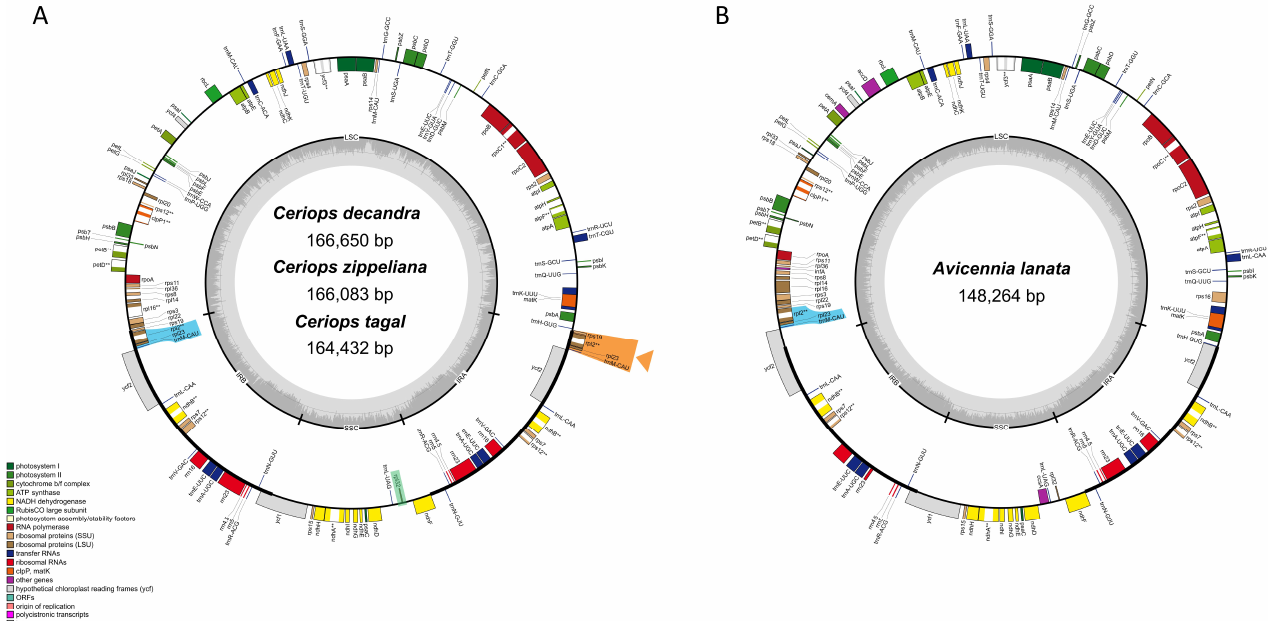
Figure 1. The chloroplast features of four mangrove species. ( A ) Complete chloroplast maps of Ceriops decandra , Ceriops zippeliana , and Ceriops tagal . ( B ) Complete chloroplast map of Avicennia lanata . Genes located outside and inside the circle are transcribed clockwise and counter-clockwise, respectively. The grey bar area in the inner circle indicates GC content of the genome, whereas the lighter grey area indicates AT content of the genome. LSC, SSC, and IRs (IRA and IRB) represent large single copy, small single copy, and inverted repeats, respectively. Genes based on different functional groups are shown in different colors. Green rectangle indicates a loss region ( rpl32 ) of C. zippeliana . Labeling in blue color indicates the same region of three genes ( rpl2 , rpl23 , and trnM-CAU ) in both Ceriops and Avicennia species, whereas labeling in orange color with an orange arrow indicates a unique region of three duplicate genes ( rpl2 , rpl23 , and trnM-CAU ) in three Ceriops species compared to A. lanata . ** indicates genes containing